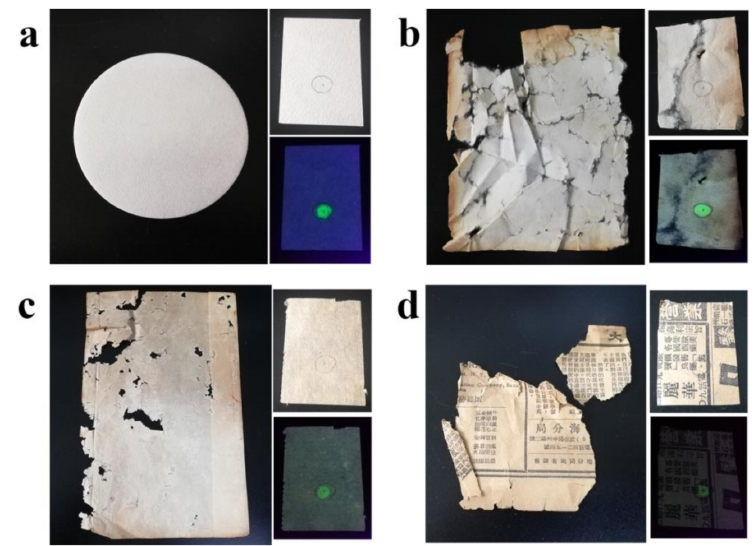
Figure 8. The photographs of four paper samples. ( a ) Filter paper. ( b ) Ancient book title page of Mianlian paper from the 19th century. ( c ) Ancient book title page of bamboo paper from the 19th century. ( d ) Newspaper:“China Times, Xuedeng” from 1922. Upper-right and lower-right corners show the photographs of paper samples containing CdZnSeS-pATP QDs under daylight and 365 nm UV light, respectively.